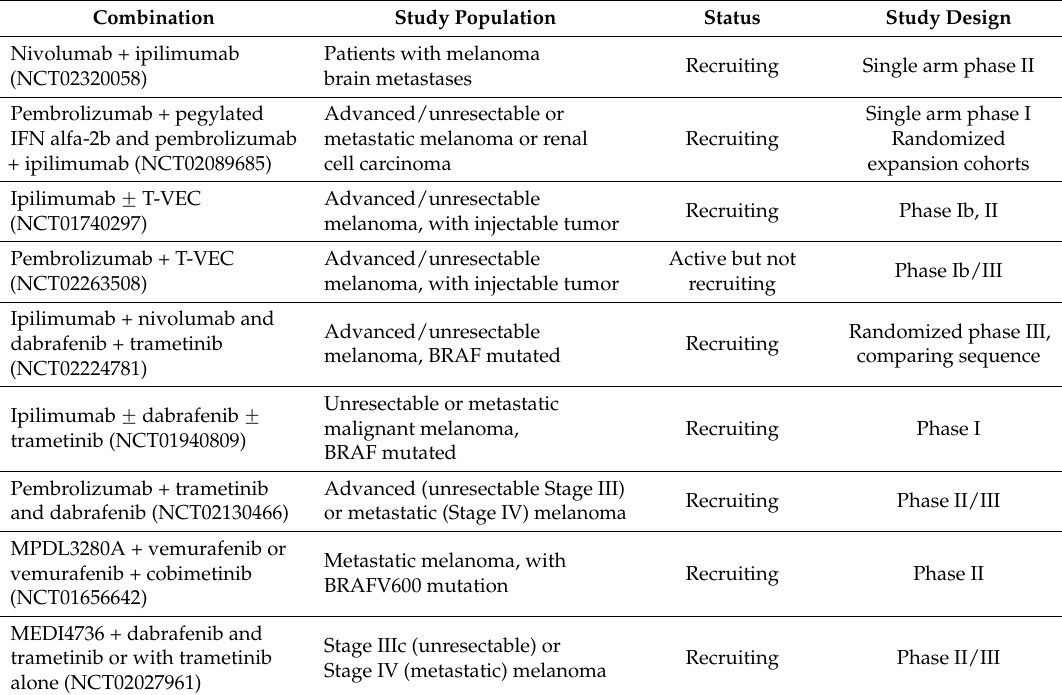
Table 3. Selected ongoing combination studies in